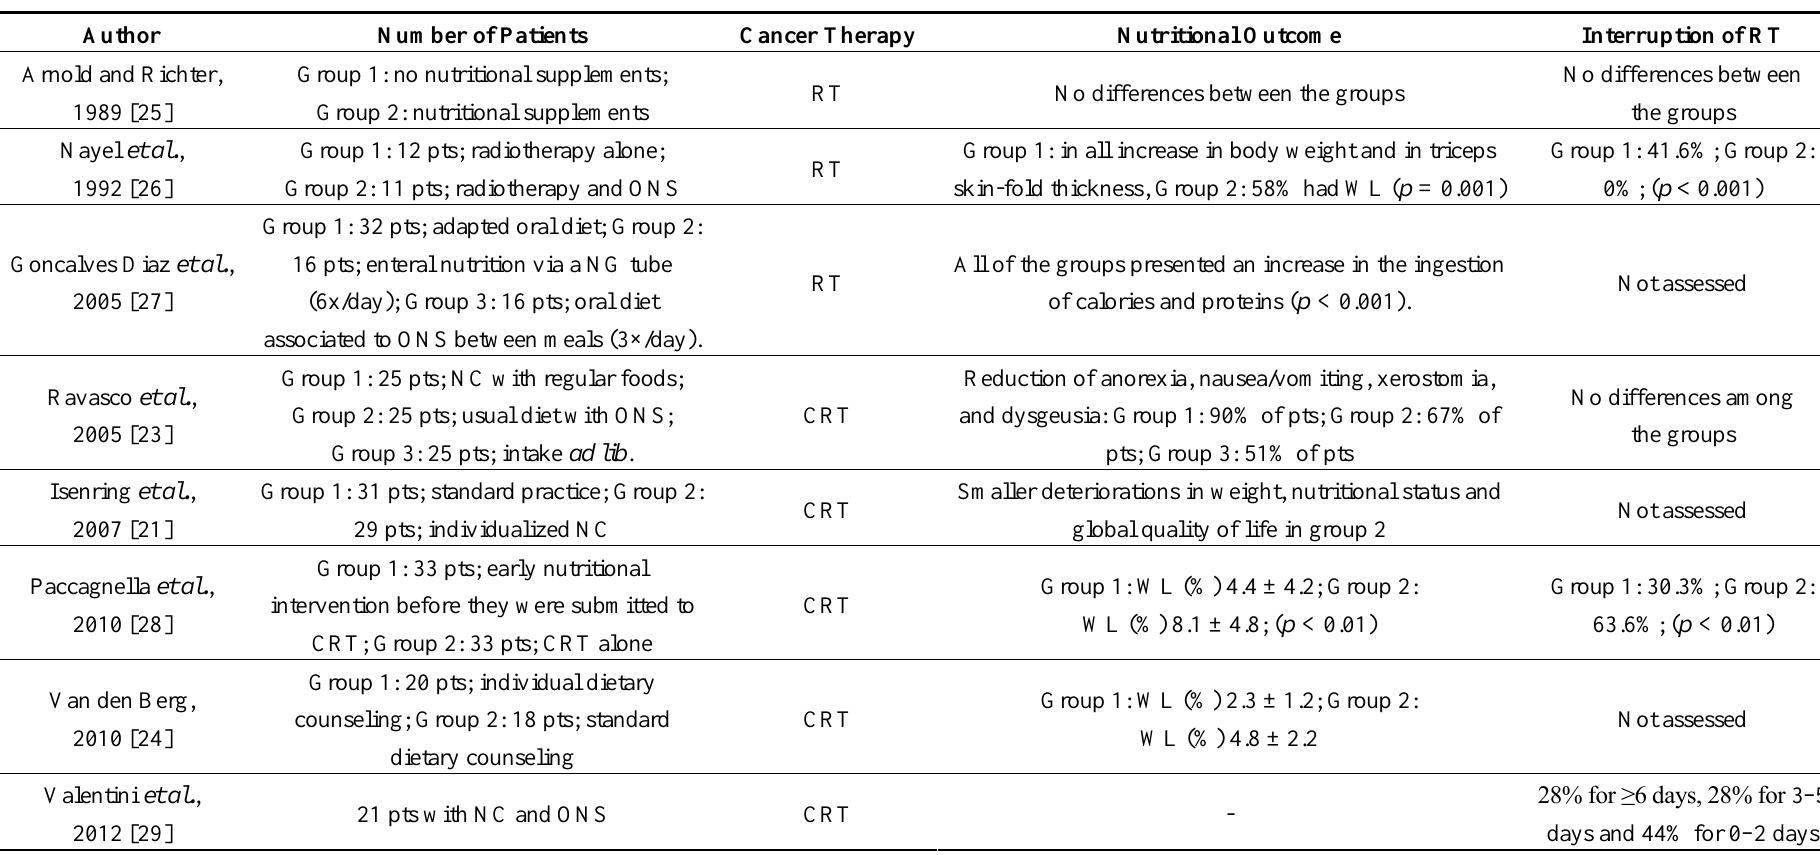
Table 1. Nutritional counseling (NC) and oral nutritional supplements (ONS) in head and neck cancer patients receiving radiotherapy (RT) or chemoradiotherapy